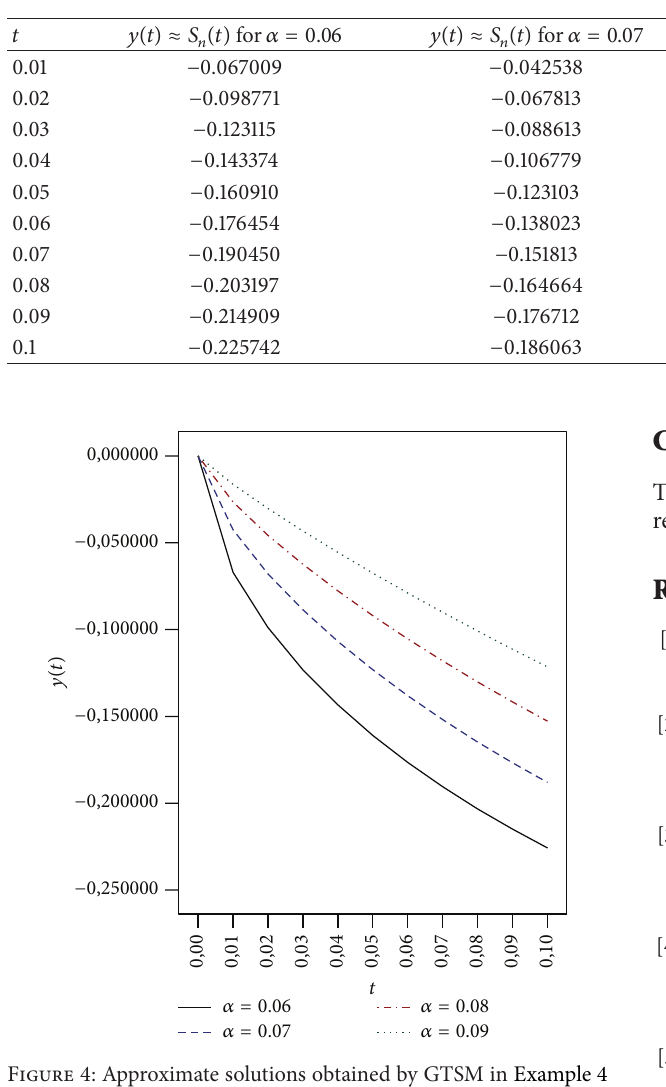
Table 11: Approximate solutions obtained by GTSM in Example 4 for different order of derivatives.